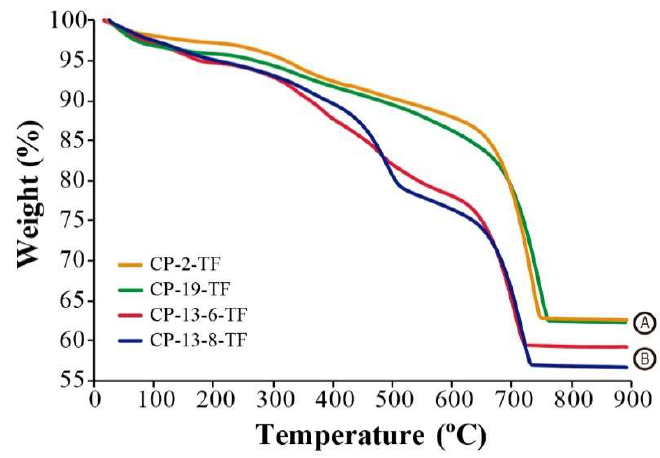
Figure 10. Thermo-gravimetric analyses of target fractions of representative mortar binders. ( A ) Binder samples with little weight loss and ( B ) binder samples with clear stepped weight loss in the 200 °C to 600 °C range . Table 3. Thermo-gravimetric analysis results (wt %) of target fractions of mortar binders.